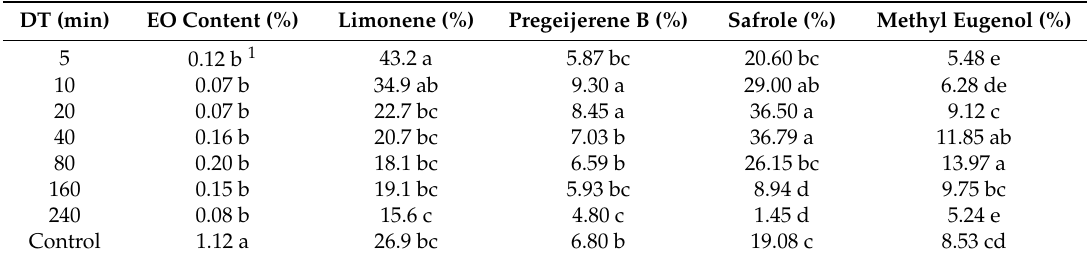
Table 1. Mean Juniperus virginiana essential oil (EO) content (%), and the concentrations (%) of limonene, pregeijerene B, safrole, and methyl eugenol in the EO fractions obtained from the eight distillation times (DT).